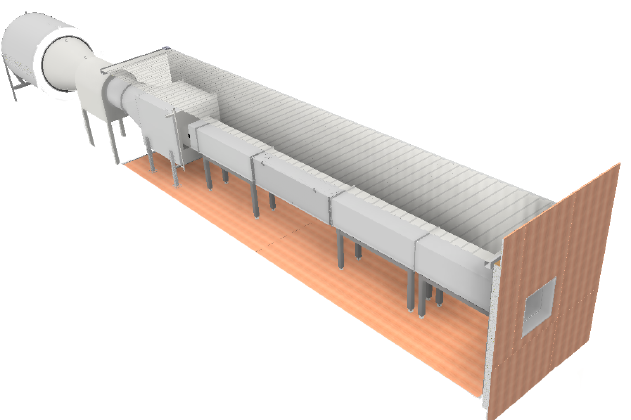
Figure 3. A 3D model of the test bench setup used for the experimental measurements of pressure